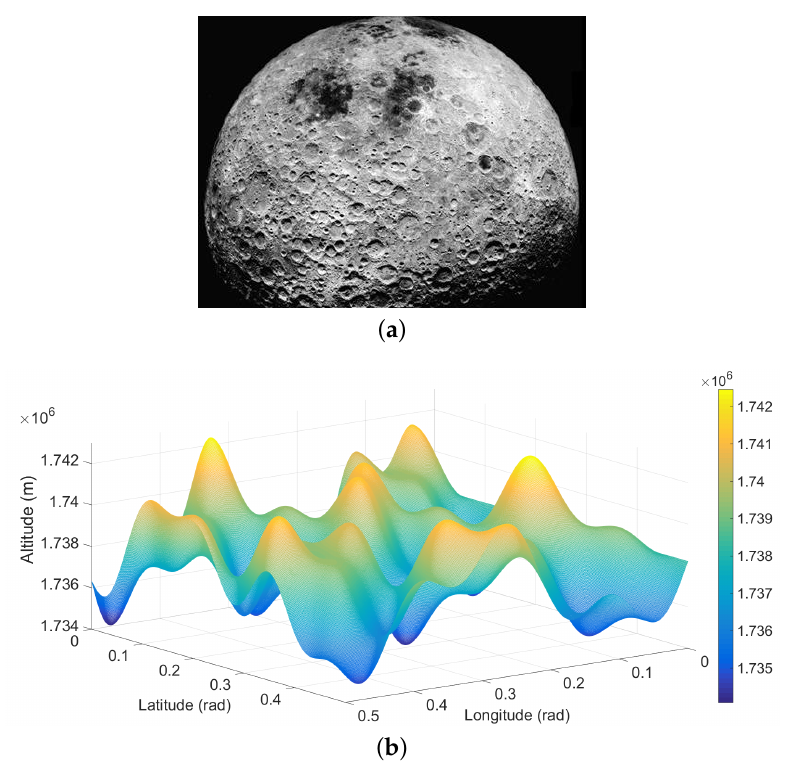
Figure 6. ( a ) The photo captured from the lunar surface; ( b ) our simulated lunar